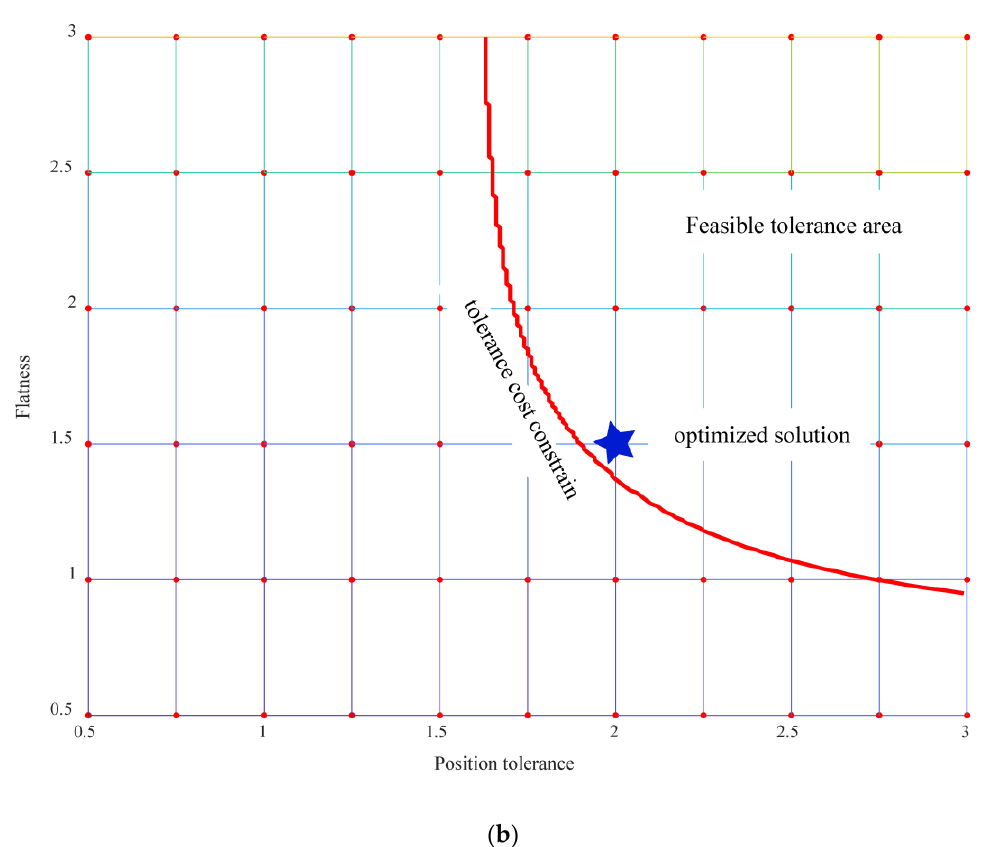
Figure 12. ( a ). The expectation of the maximum power density degradation for different hybrid tolerances T and F . ( b ). The constraint of the tolerance